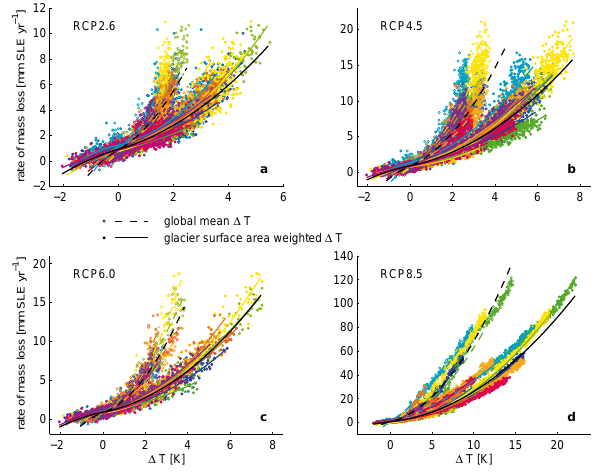
Fig. 6. Global glacier mass balance, expressed in terms of global mean sea level equivalent (SLE), as a function of anomalies in (1) global mean (open circles, dashed lines) and (2) glacier area weighted (filled dots, solid lines) temperature. Results refer to the constant hypsometry, infinite volume scenario. Colored lines show quadratic fits for each individual CMIP5 model, black lines show fits based on mean parameters of colored lines. Colors as in Fig. 2. Different panels refer to different